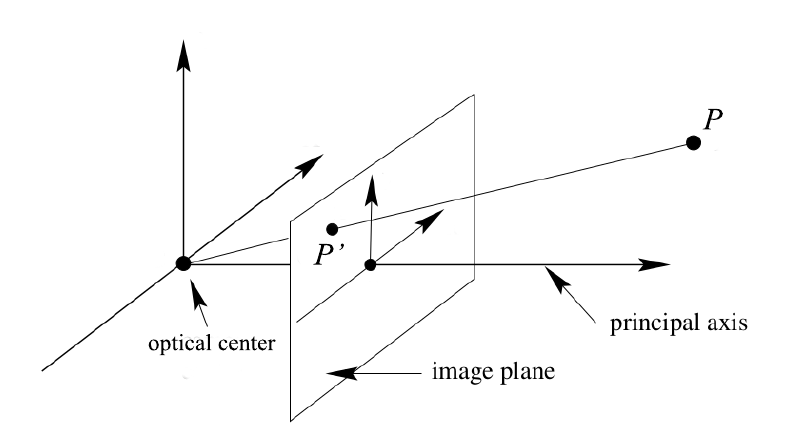
Figure 11. Pinhole camera